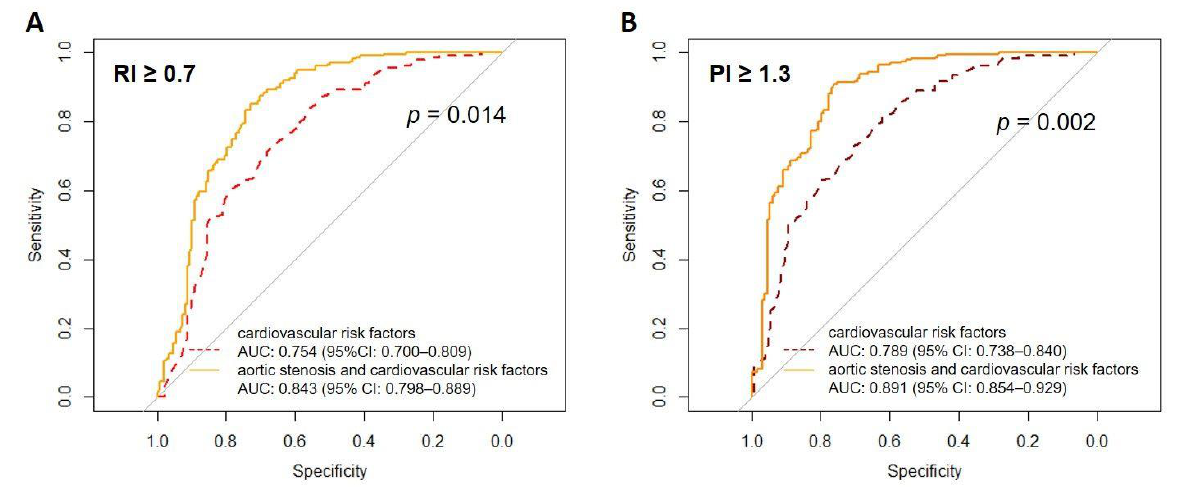
Figure 2. Comparison of area under the curve (AUC) for multivariate models to detect increased Resistive Index (panel ( A )) and Pulsatile Index (panel ( B )). Baseline models AUCs for CRF are presented as dashed lines, AUCs for degenerative aortic stenosis are presented as solid lines. Abbreviations: AUC—area under the curve; PI—Pulsatile Index; RI—Resistive Index.